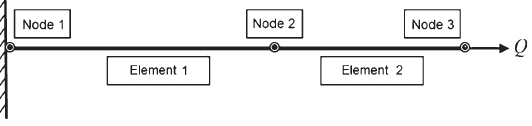
Fig.5. Definitionoftheelementsandnodesfortheone-dimensional geometry of a trabecula